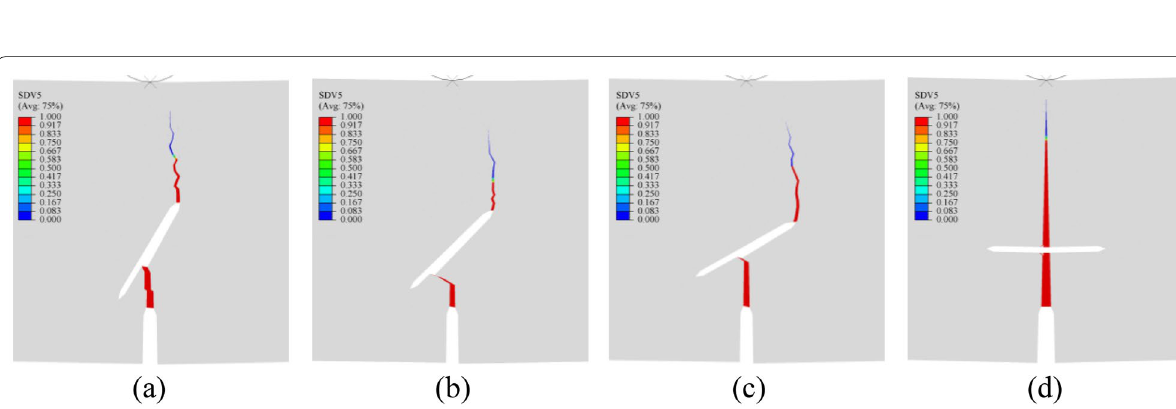
Fig. 15 The representative principal strain fields of the specimens with ( a ) θ 1 mm/s